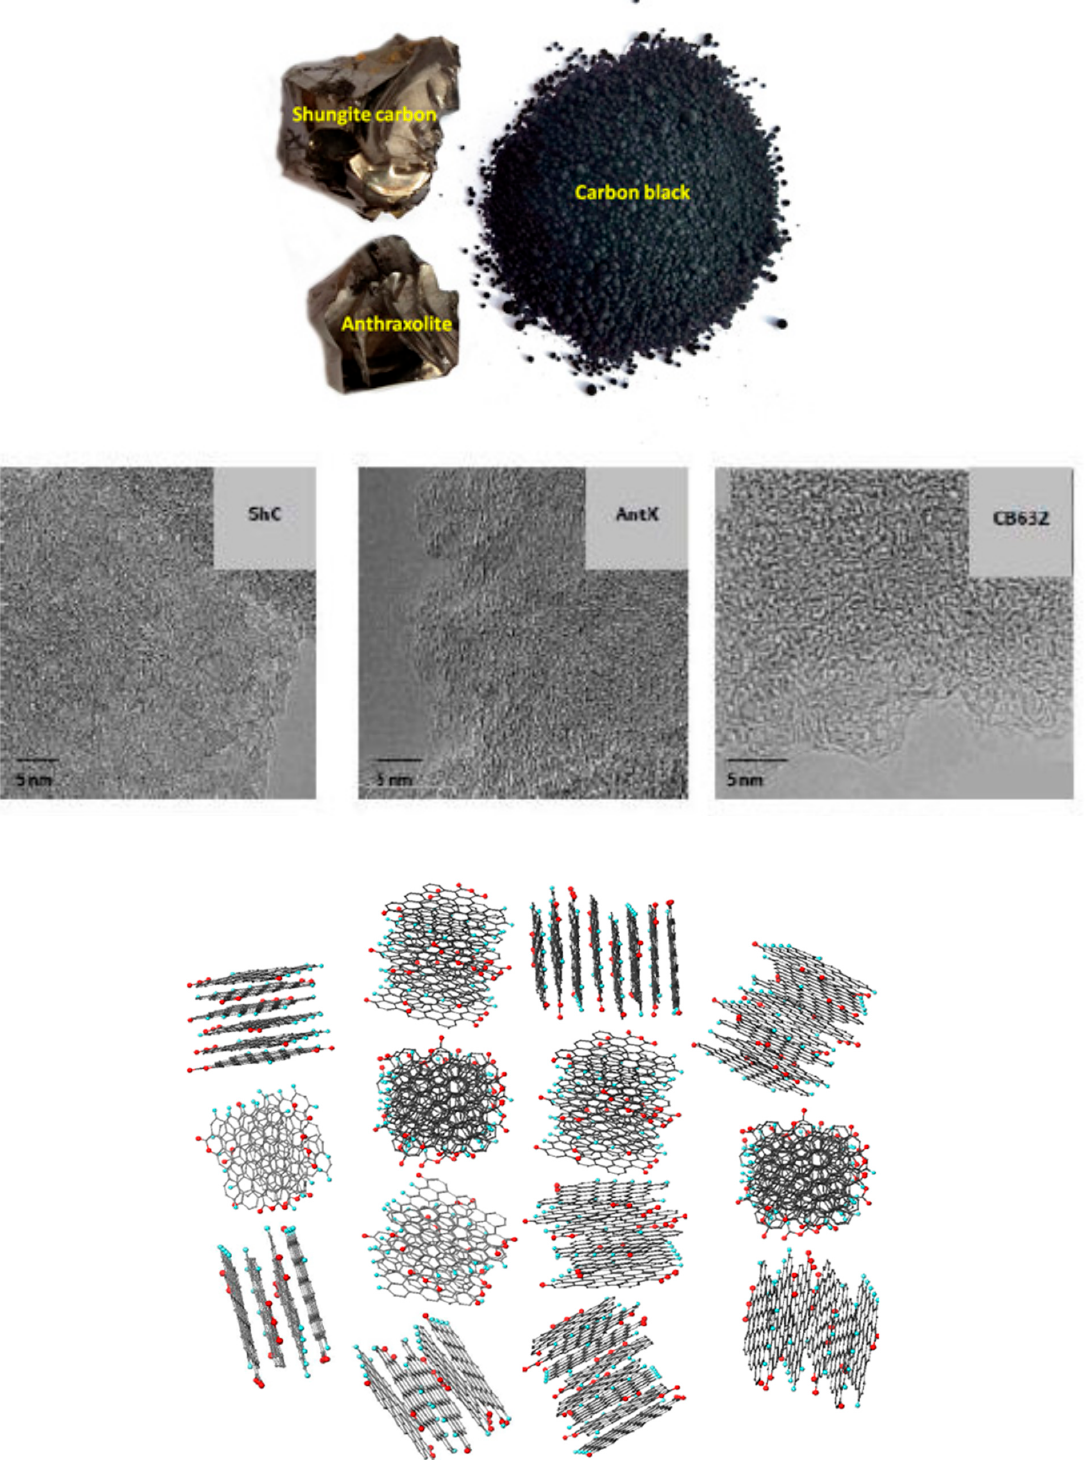
Figure 1. Appearance ( top ) and TEM image ( middle ) of natural amorphous carbon. Planar view ( bottom ) on a model globule of shungite carbon consisting of four-, five-, six-, and seven-layer stacks of basic structure units (BSUs). Linear dimension of the globe is of ~6 nm. The chemical composition of all the BSUs is described by the formula C 66 O 4 H 6 . Dark gray, light blue, and red balls depict carbon, hydrogen, and oxygen atoms,